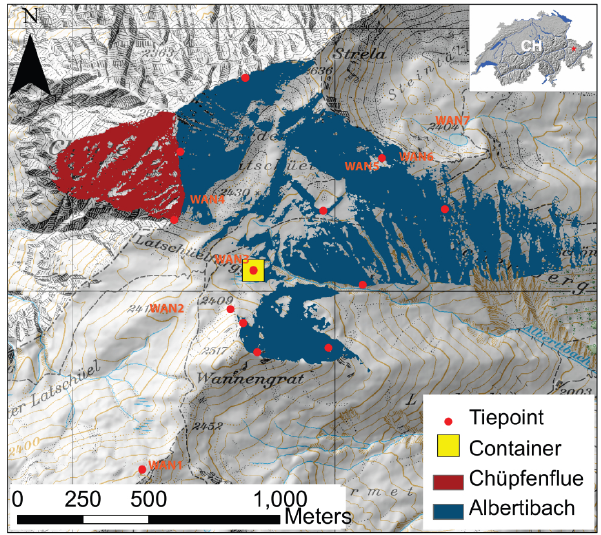
Fig. 1. Overview of the study site Wannengrat (region of Davos, Switzerland). Snow depths were measured with a terrestrial laser scanner (TLS) in the south-west face of the Ch¨upfenflue and in the catchment of Albertibach. The used equipment was stored in a container. To convert the TLS point-cloud into a Swiss coordi- nate system several fixed-installed reflectors (tie points) were used. Seven automatic weather stations (WAN1 to WAN7) deliver impor- tant additional information (e.g. temperature, wind-direction). For measurements in the Ch¨upfenflue the TLS was positioned next to the weather station